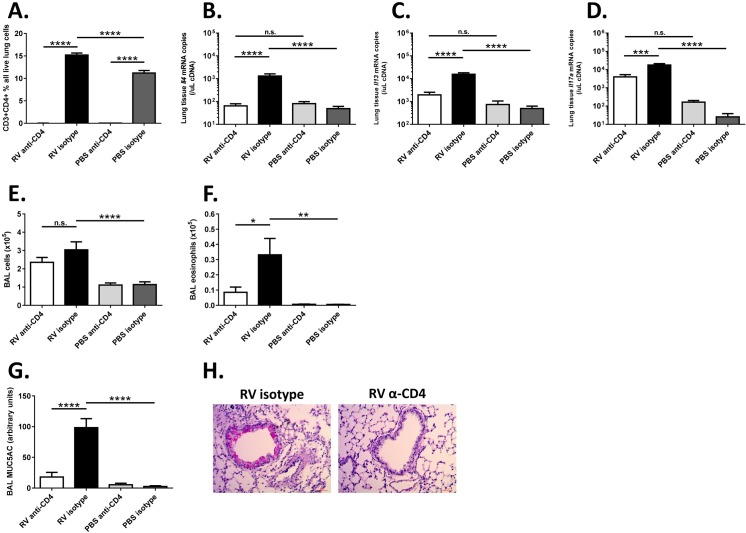
Asthma-like airways inflammation is CD4+ T cell dependent.Tbet-/- mice were infected intranasally with RV1B or sham infected with PBS. In addition, mice were systemically depleted of CD4 expressing cells (anti-CD4), or treated with isotype control antibody (isotype) 3hrs prior to infection. Tissues were harvested at 7 days post-challenge. (A) Lung flow cytometry staining for CD3+CD4+ T cells. (B-D) Levels of cytokines IL-4 (B), IL-13 (C) and IL-17a (D) in lung tissue measured by Taqman qPCR. (E) Total BAL cell counts and (F) eosinophil counts in BAL measured by cytospin assay. (G) MUC5AC levels in BAL measured by ELISA. (H) Representative PAS staining for mucus in lung tissue sections. Scale bars 50μm. n = 12–15 mice/group (mice for which CD4+ cell depletion was not successful were excluded from all analyses (n = 5 of 30)). ***p<0.001, **p<0.01, *p<0.05, n.s. not significant.